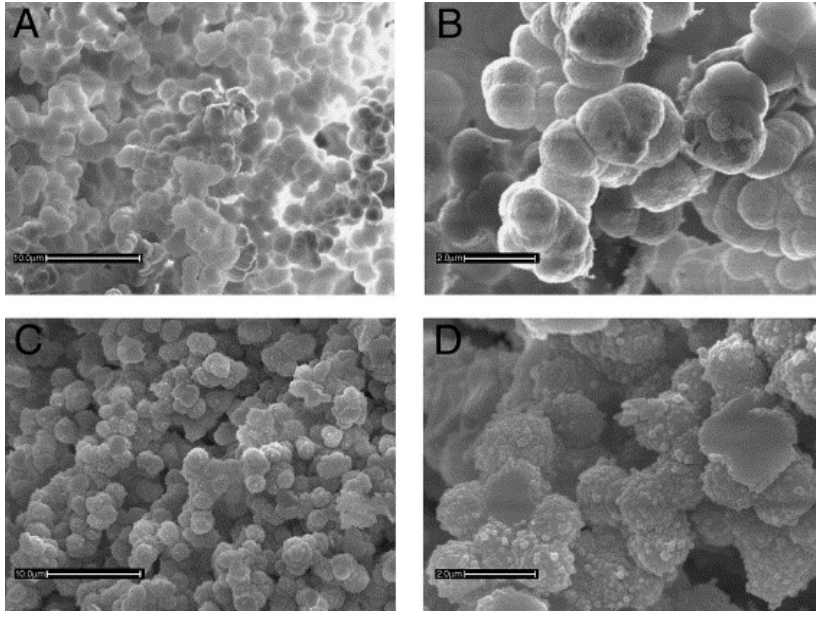
Figure 6. Scanning electron micrographs of (A) nongrafted core monolith at magnification 3,000×; (B) nongrafted core monolith at magnification 10,000×; (C) grafted BV-mMIP at magnification 3,000× and (D) grafted BV-mMIP at magnification 10,000× [126]. Reprinted with permission from